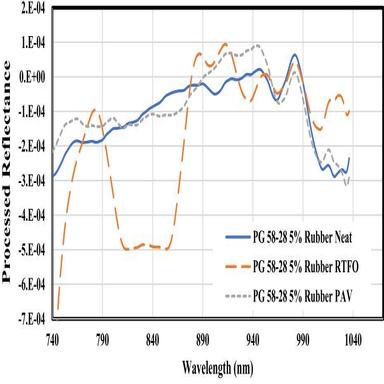
Comparison of the PG 58-28 binders with 5% rubber at different aging levels.